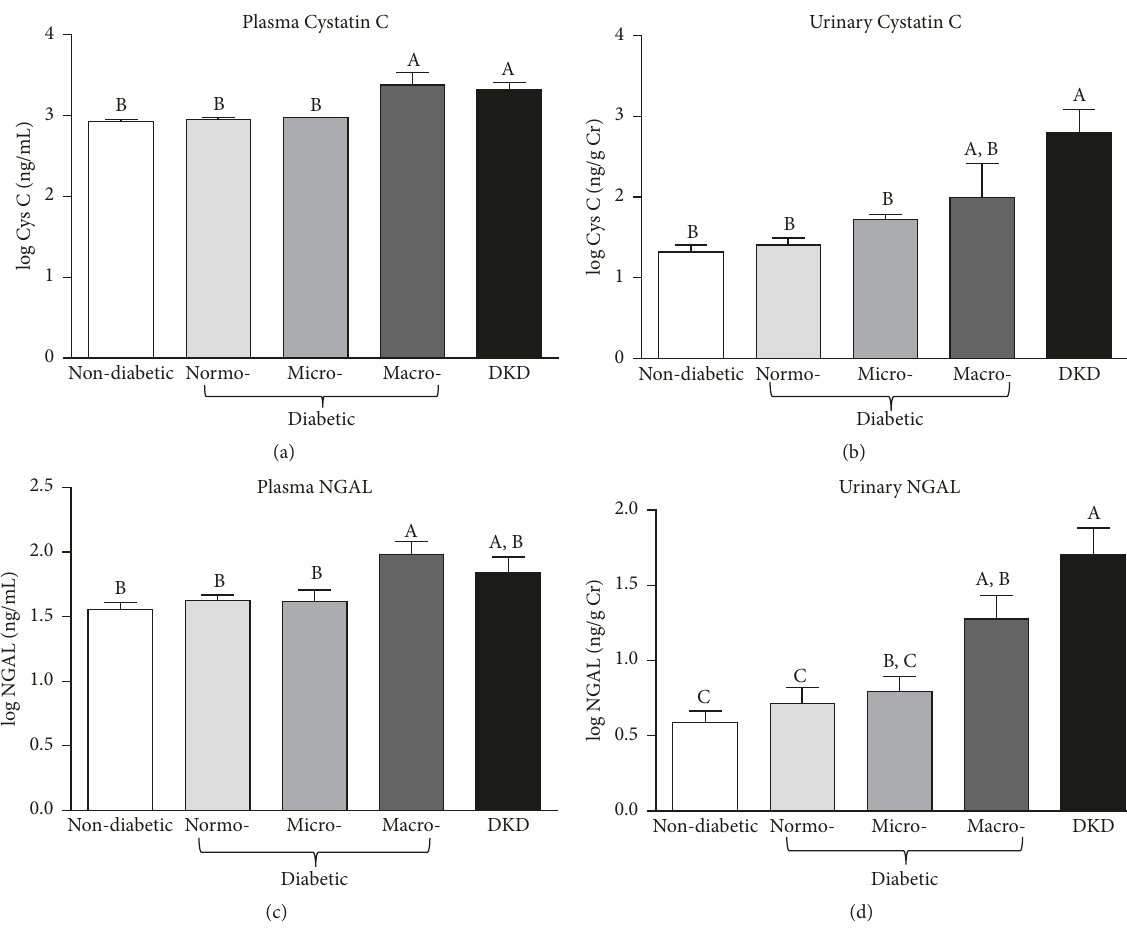
Figure 6: Cystatin C and neutrophil gelatinase-associated lipocalin (NGAL) levels. (a)-(b) Log-transformed plasma (a) or urinary (b) cystatin C levels among nondiabetic subjects, diabetic patients with normo-, micro- or macroalbuminuria, and diabetic patients with diagnosed kidney disease (DKD). Urinary cystatin C levels were normalized to urinary creatinine. (c)-(d) Log-transformed plasma (c) and urinary (d) NGAL levels among nondiabetic subjects, diabetic patients with normo-, micro- or macroalbuminuria, and diabetic patients with diagnosed kidney disease (DKD). Urinary NGAL levels were normalized to urinary creatinine. Data are represented as mean ± SEM. Labeled means without a common letter are significantly different from one another (𝑝 < 0.05) based on one-way ANOVA and Tukey’s honest significant difference